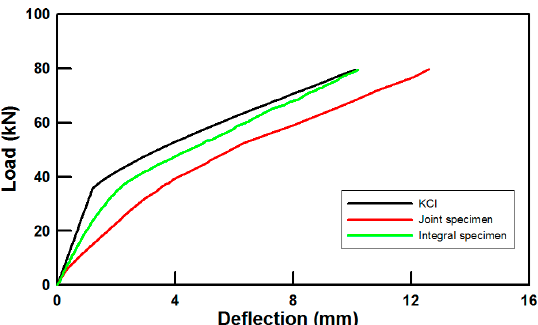
Figure 6. Load and deflection curves of initial loading. KCI: Korea Structural Concrete Design Code.